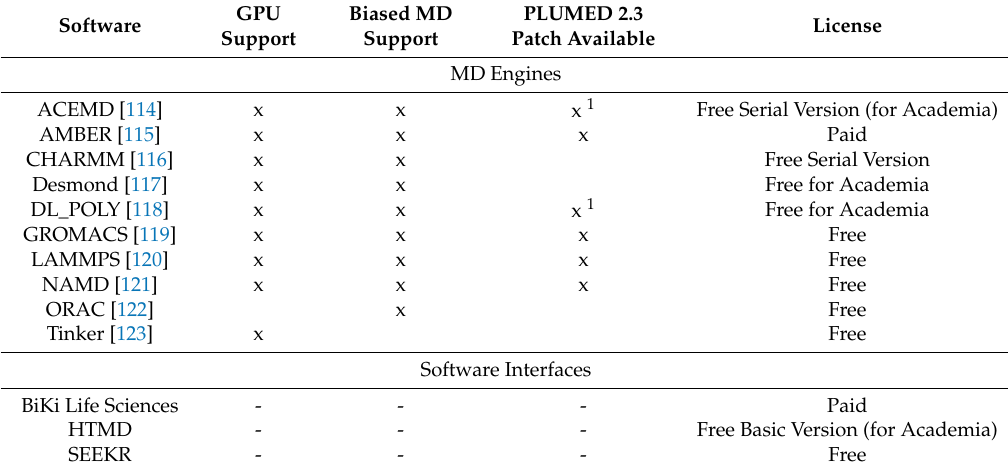
Table 3. Examples of MD software that can be used to perform dynamic docking